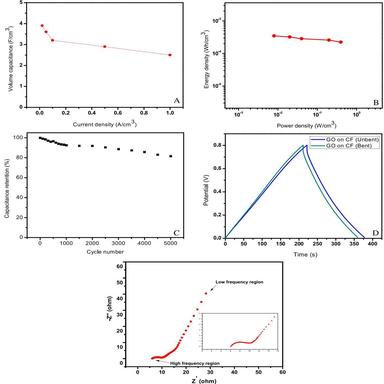
(a) Volumetric capacitance of the device with respect to scan rates (current density), (b) A Ragone plot of the device, (c) The curve showing the percentage retention of the capacitance with number of cycles of the supercapacitor, (d) Comparison of the charge-discharge of the ultra-long flexible cable supercapacitor device in bent and unbent forms and (e) Electrochemical impedance spectroscopy (EIS) of GO grafted on CF sample in gel electrolyte.